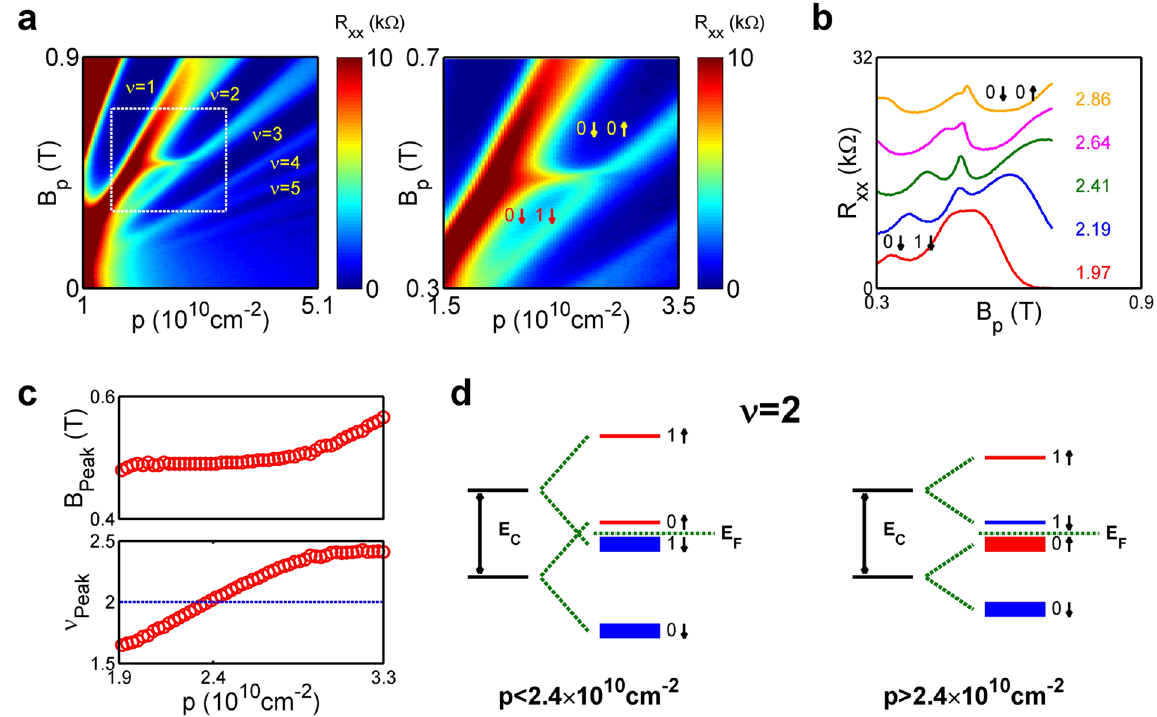
Figure 2. ( a ) R xx of 2D holes in Ge as a function of p and B p . Prominent filling factors are labeled in yellow. A zoom-in view of the quantum Hall ferromagnetic transition is shown on the right panel. The lowest two filled Landau levels before and after the transition are labeled. ( b ) Line cuts along the B p direction at five densities near the transition, showing the evolution of the resistance peak due to magnetic domains. ( c ) The position and the corresponding filling factor of the resistance peak as a function of p . ( d ) The alignment of the four lowest Landau levels before and after the transition at p = 2.4 × 10 10 cm − 2 . The Fermi level is between the second and the third lowest spin-polarized Landau levels, corresponding to ν =